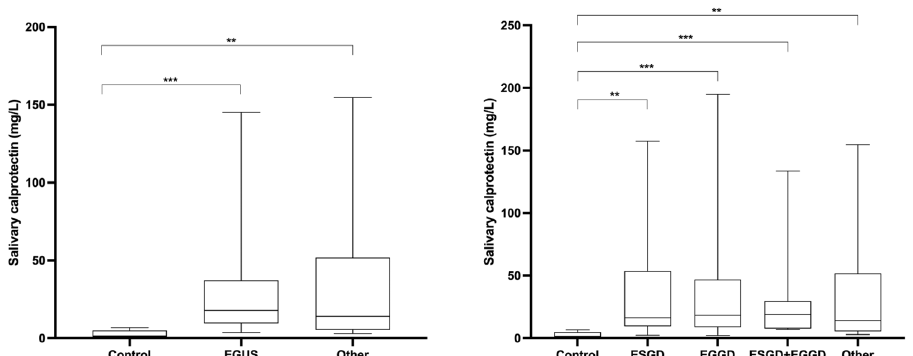
Figure 2. Salivary calprotectin concentrations observed in healthy horses (Control), horses diagnosed with equine gastric ulcer syndrome (EGUS), and horses with similar symptomatology of EGUS but diagnosed with other gastrointestinal disorders (Other). The median values are represented by the lines, the 10–90 percentiles by the boxes, and the range by the whiskers. **: p < 0.01; ***: p < 0.001.